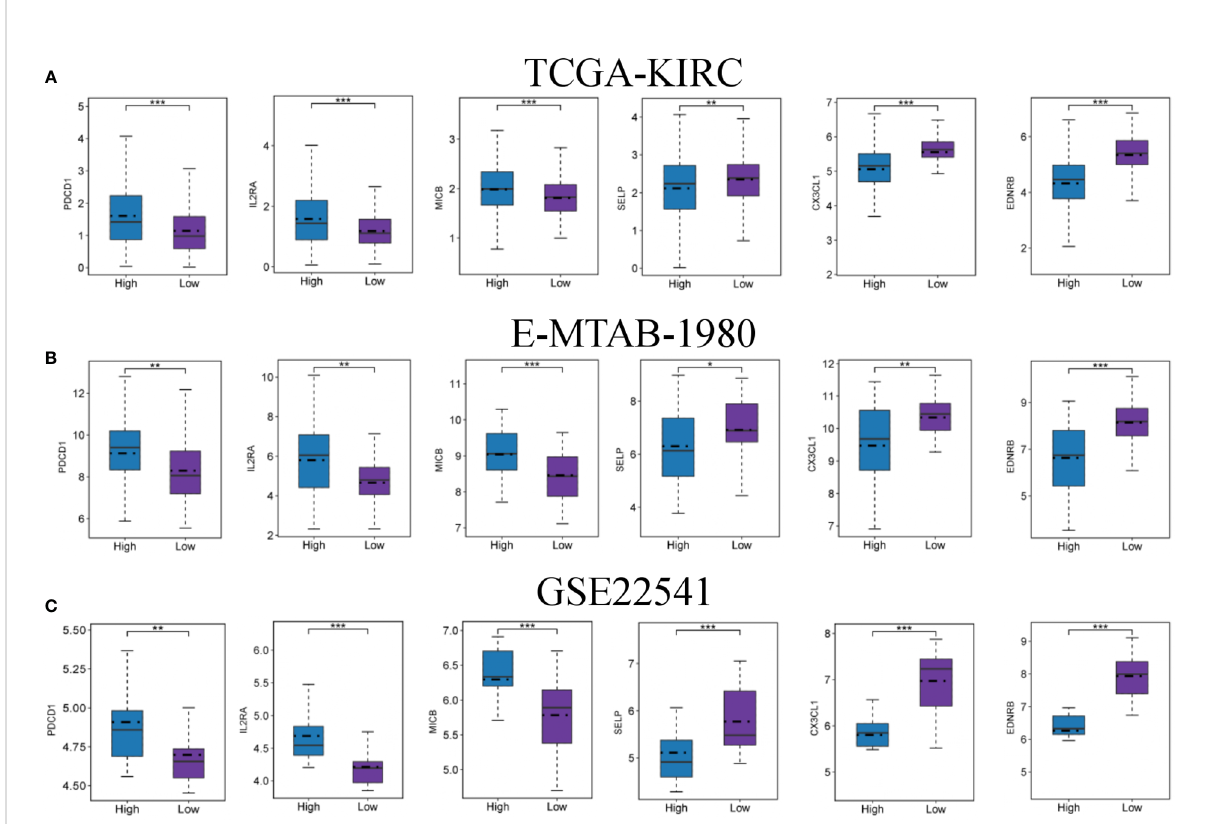
FIGURE 7 Expression levels of immune checkpoints in the high- and low-FMI group. Expression level of PDCD1, IL2RA, MICB, SELP, CX3CL1 and EDNRB in TCGA-KIRC (A) , E-NTAB-1980 (B) , and GSE22541 (C) cohorts. * P < 0.05; ** P < 0.01; *** P <